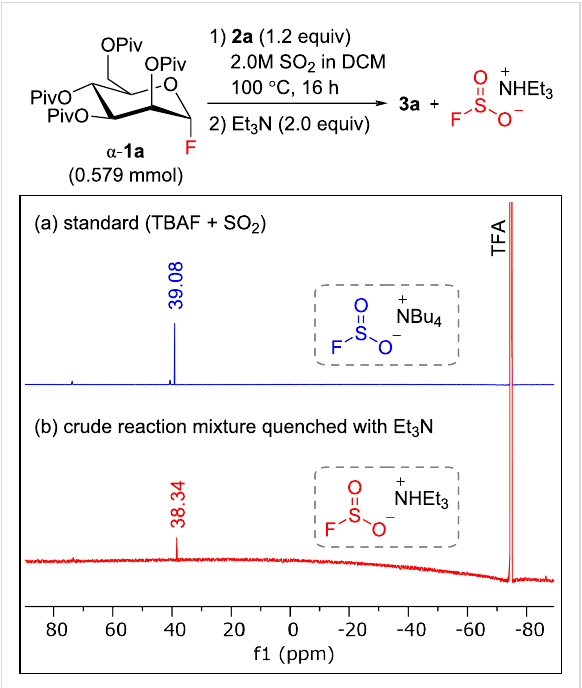
Figure 1: Detection of the FSO 2 − species by 19 F NMR (471 MHz, D 2